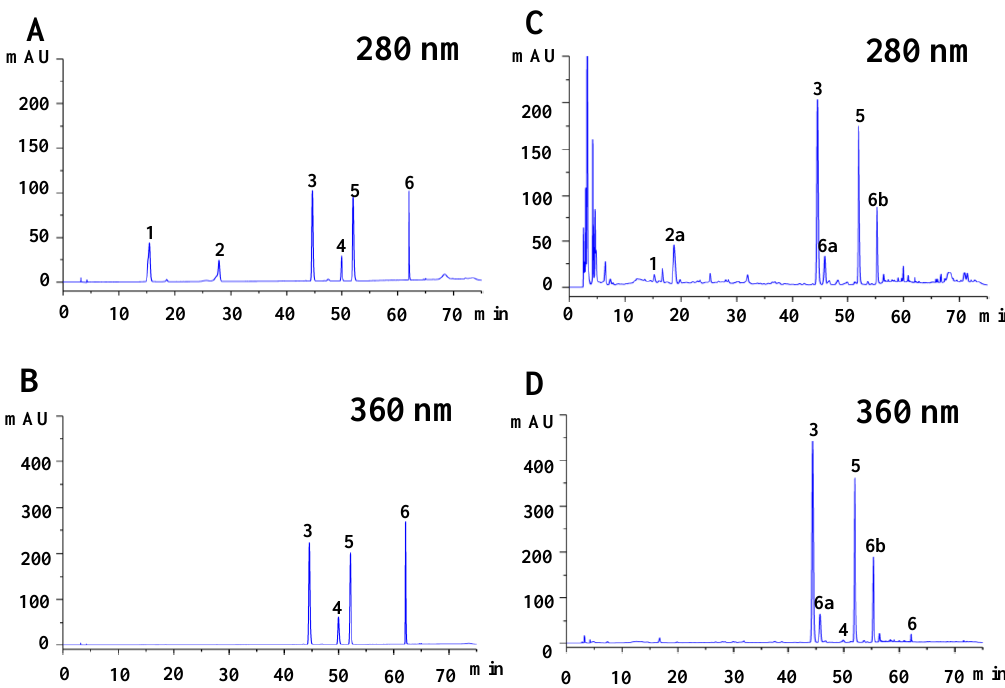
Figure 1. High performance liquid chromatograms of mixed standards ( A and B ) and the representative cultivar (“Shuiguo”) of okra fruit ( C and D ); 1 , protocatechuic acid; 2 , catechin; 3 , quercetin-3-O-gentiobioside; 4 , rutin; 5 , isoquercitrin; 6 , quercetin; 2a , catechin derivative; 6a , quercetin derivative a; 6b , quercetin derivative b.